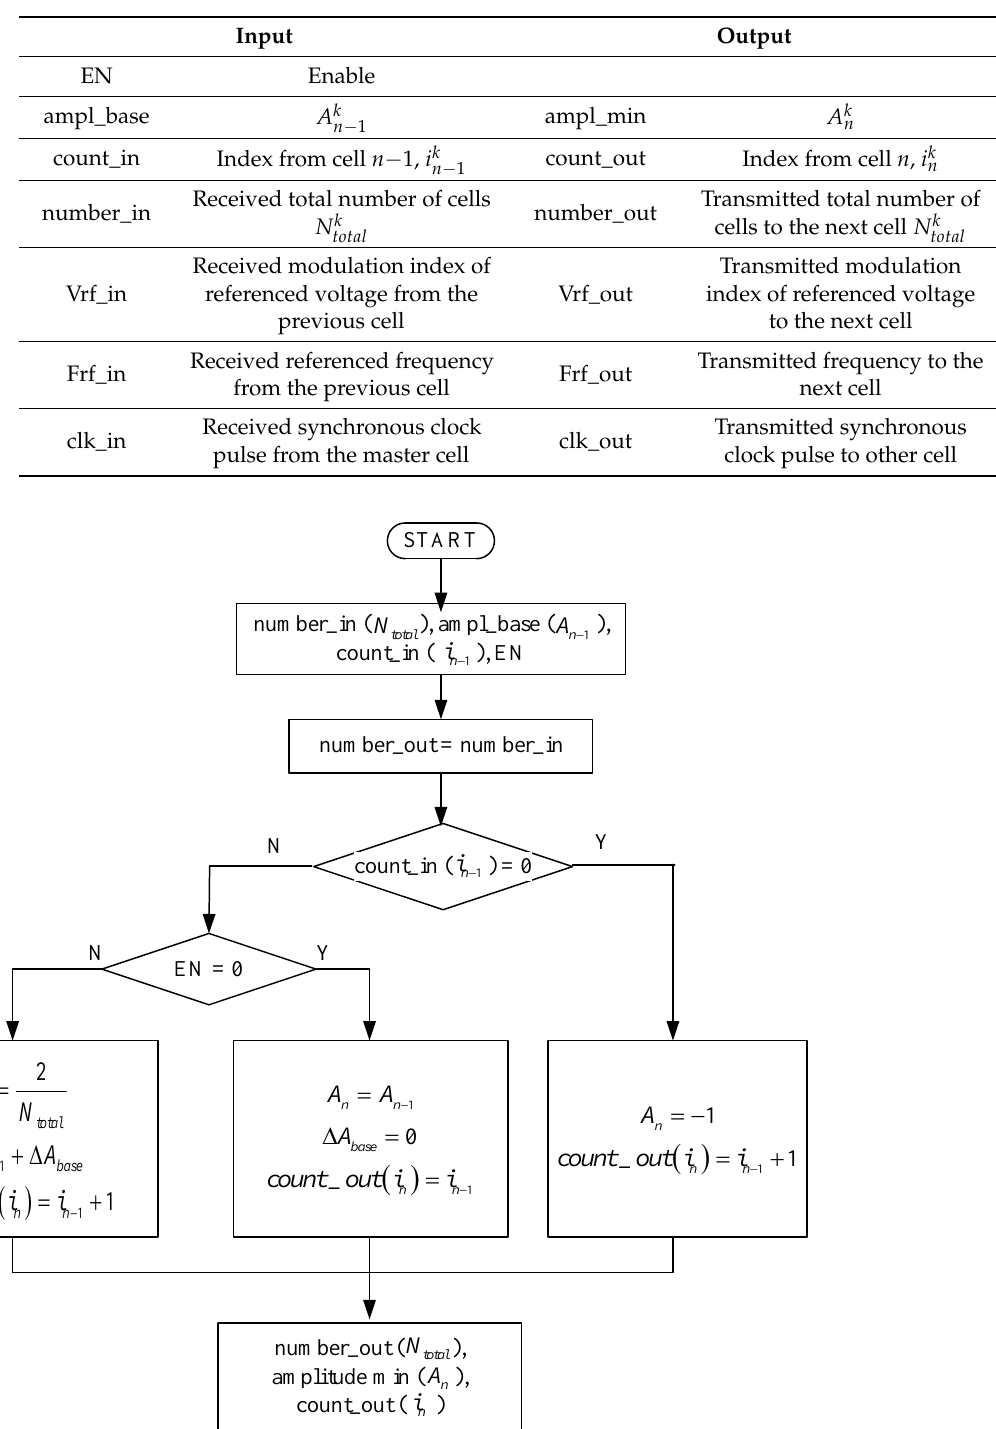
Table 2. Input and output of cell controller with DSA-LSC method.